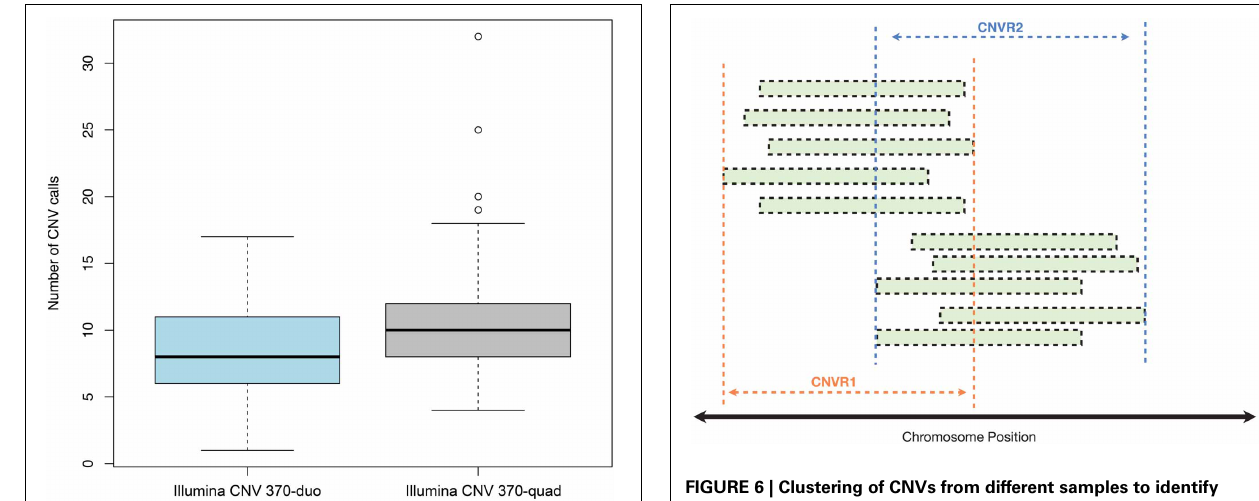
FIGURE 6 | Clustering of CNVs from different samples to identify common CNV regions (CNVRs). In this illustrated example, each green bar represents a CNV call detected in a single individual (either a case or control). CNVs with reciprocal overlap of at least 40% were clustered into the same